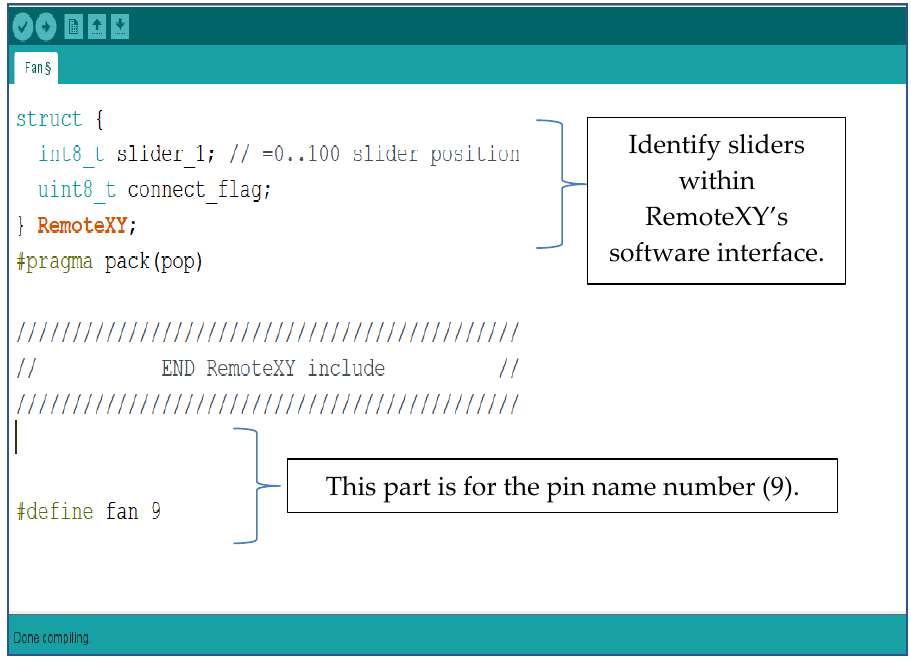
Figure A4. The second part of the executed code used to control the fan speed.